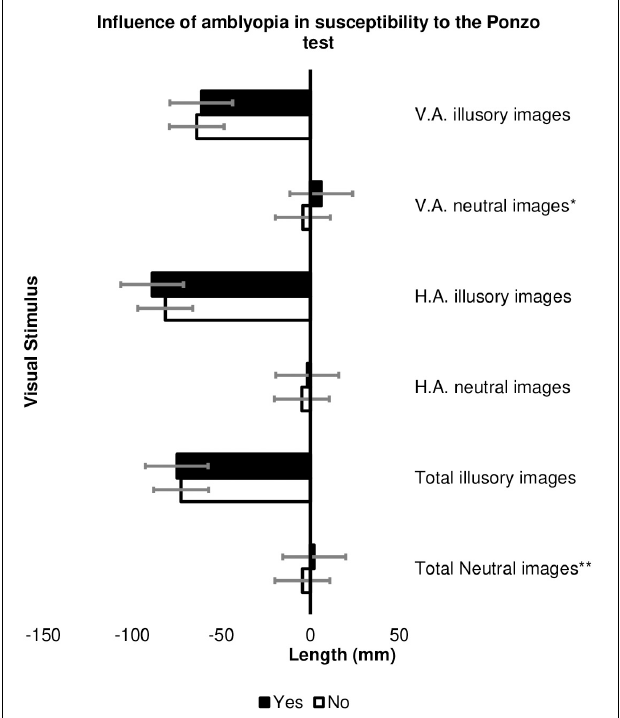
FIGURE 6 | Influence of the presence of amblyopia on the estimation of image size (in millimeters) in the Ponzo test in the Cases Group among patients with strabismus and amblyopia ( n = 8) and patients with strabismus but without amblyopia ( n = 37). HA, horizontal adjustment; VA, vertical adjustment; * p -value = 0.005, ** p -value = 0.046. The error bars shown represent the Standard